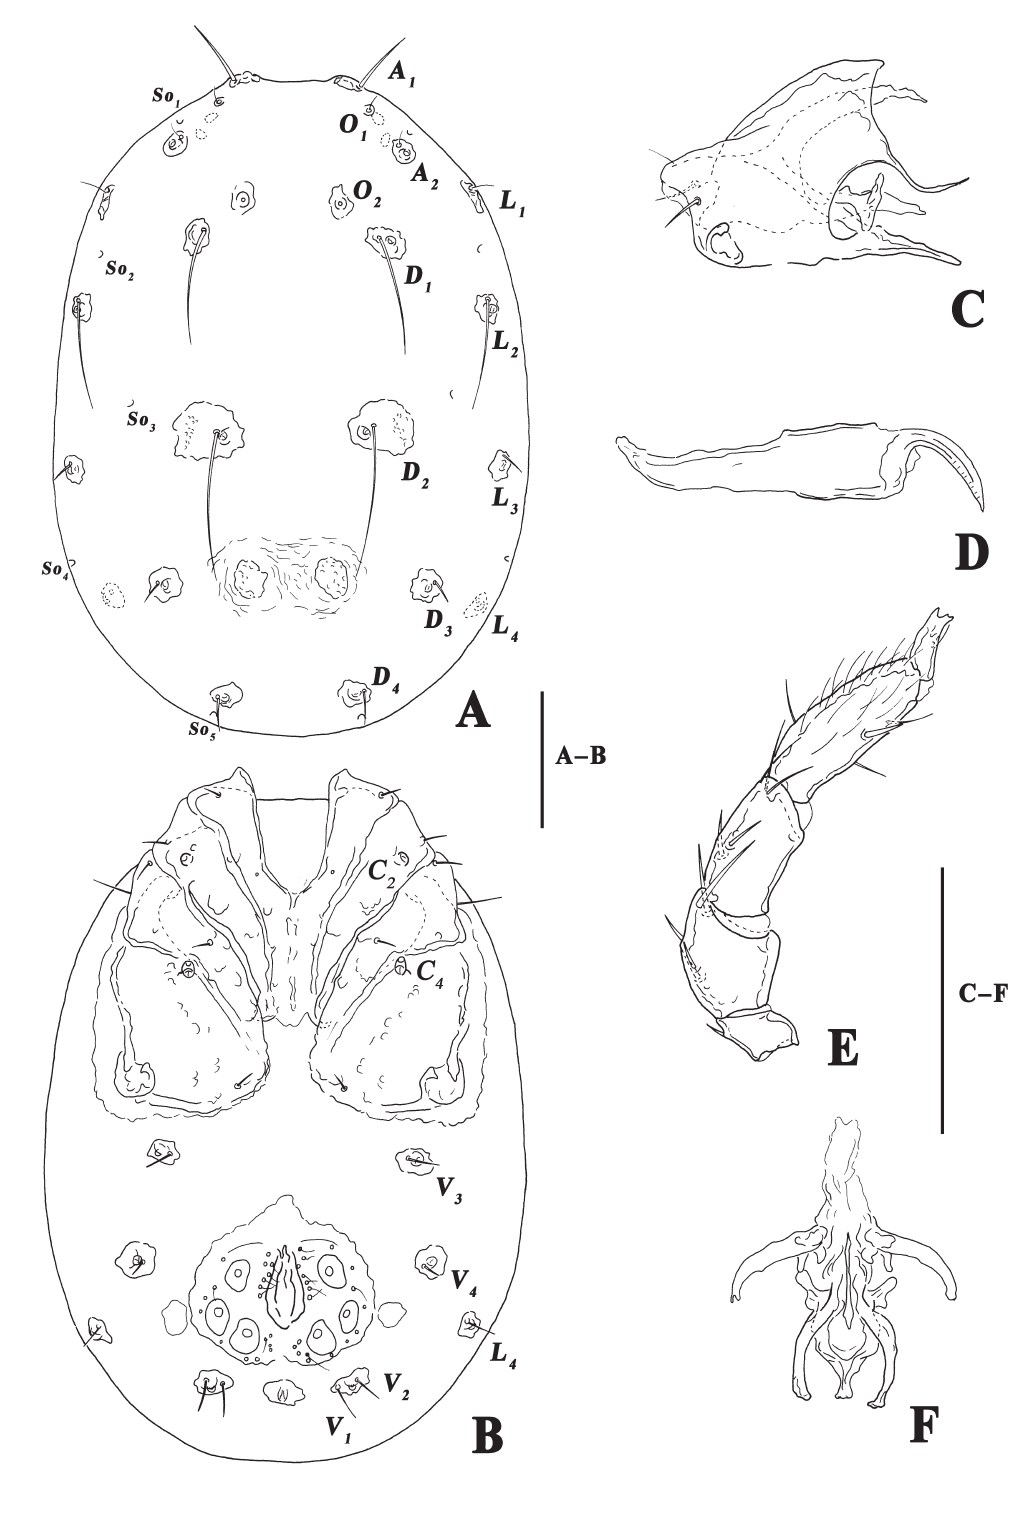
Fig. 4. Atractides ( Atractides ) smiti Zhang, Li & Guo sp. nov., holotype, ♂ ( GUGC, Slide No. QH- HY-2020071706). A . Idiosoma, dorsal view. B . Idiosoma, ventral view. C . Gnathosoma. D . Chelicera. E . Palp. F . Ejaculatory complex. Scale bars = 100